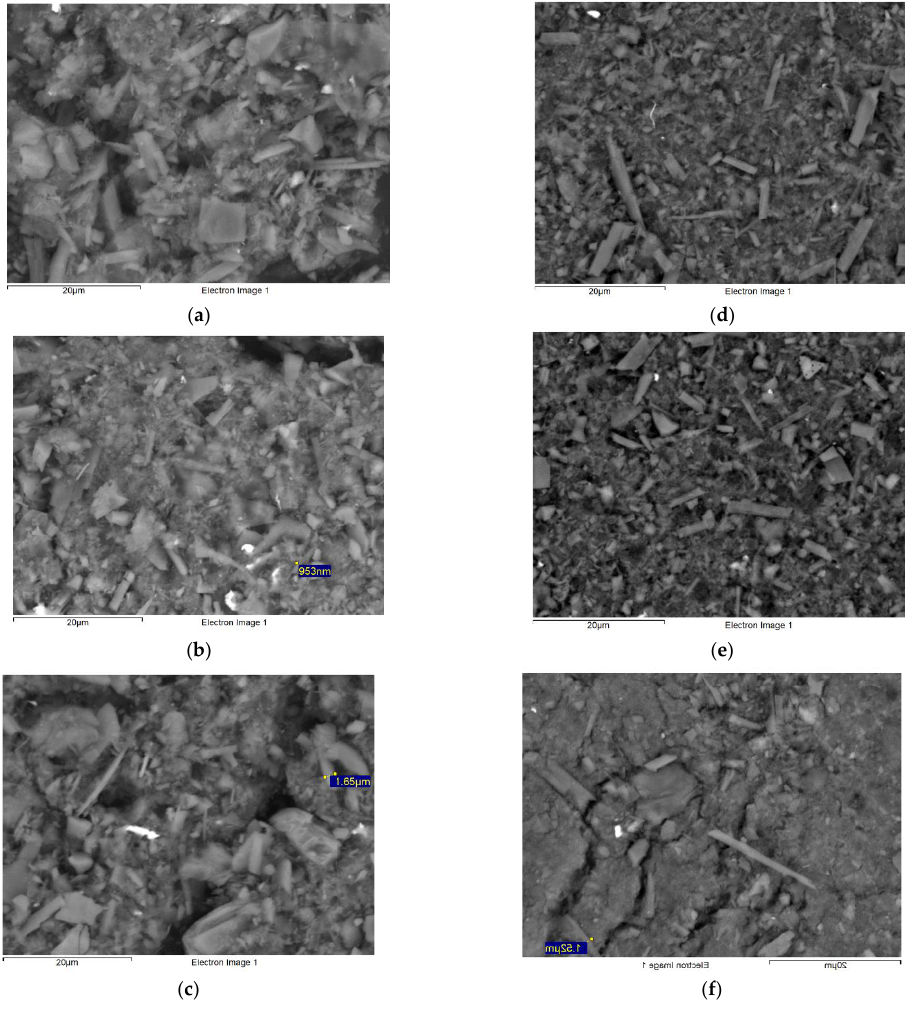
Figure 2. SEM images of α -spodumene concentrate samples following typical comminution and beneficiation for chemical grade ( a – c ) and technical grade ( d – f ) illustrate the morphology of EMP with the majority exhibiting stepped sides with blunt or stepped ends consistent with α -spodumene cleavage fragments. In the 10 images examined of chemical grade concentrate, 47 particles were identified